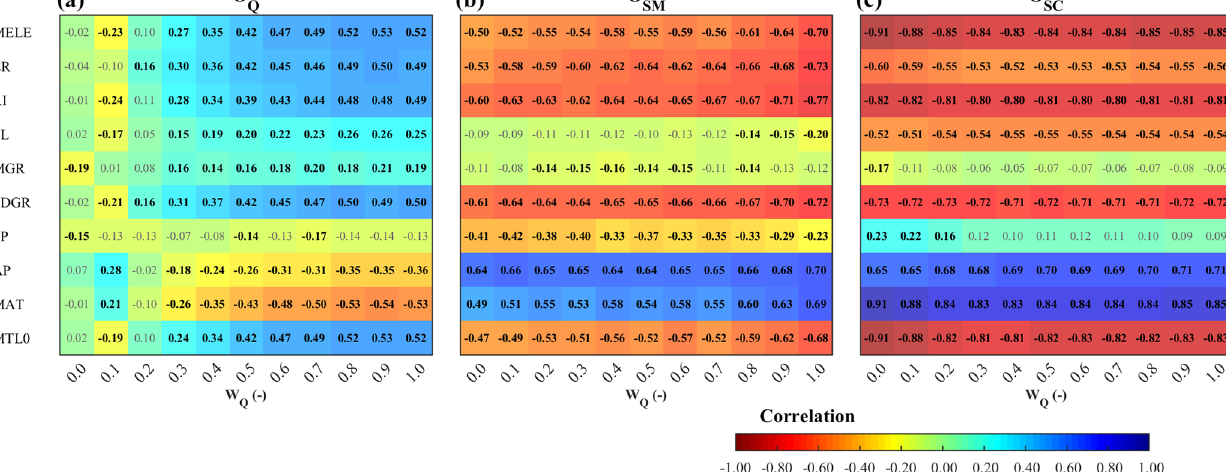
Figure 6. Correlation between catchment attributes (Table 1; other attributes can be found in Fig. S2) and model performance, i.e., runoff (Eq. 2; a ), soil moisture (Eq. 5; b ), and snow cover (Eq. 6; c ) obtained from multiple objective calibration to satellite soil moisture (ASCAT), satellite snow cover (MODIS), and runoff (var3 of Table 5; SSM + SCM + runoff) in the validation period 2010–2014. Cool and warm colors represent positive and negative correlations, respectively. Text in bold print indicates significance with p values lower than